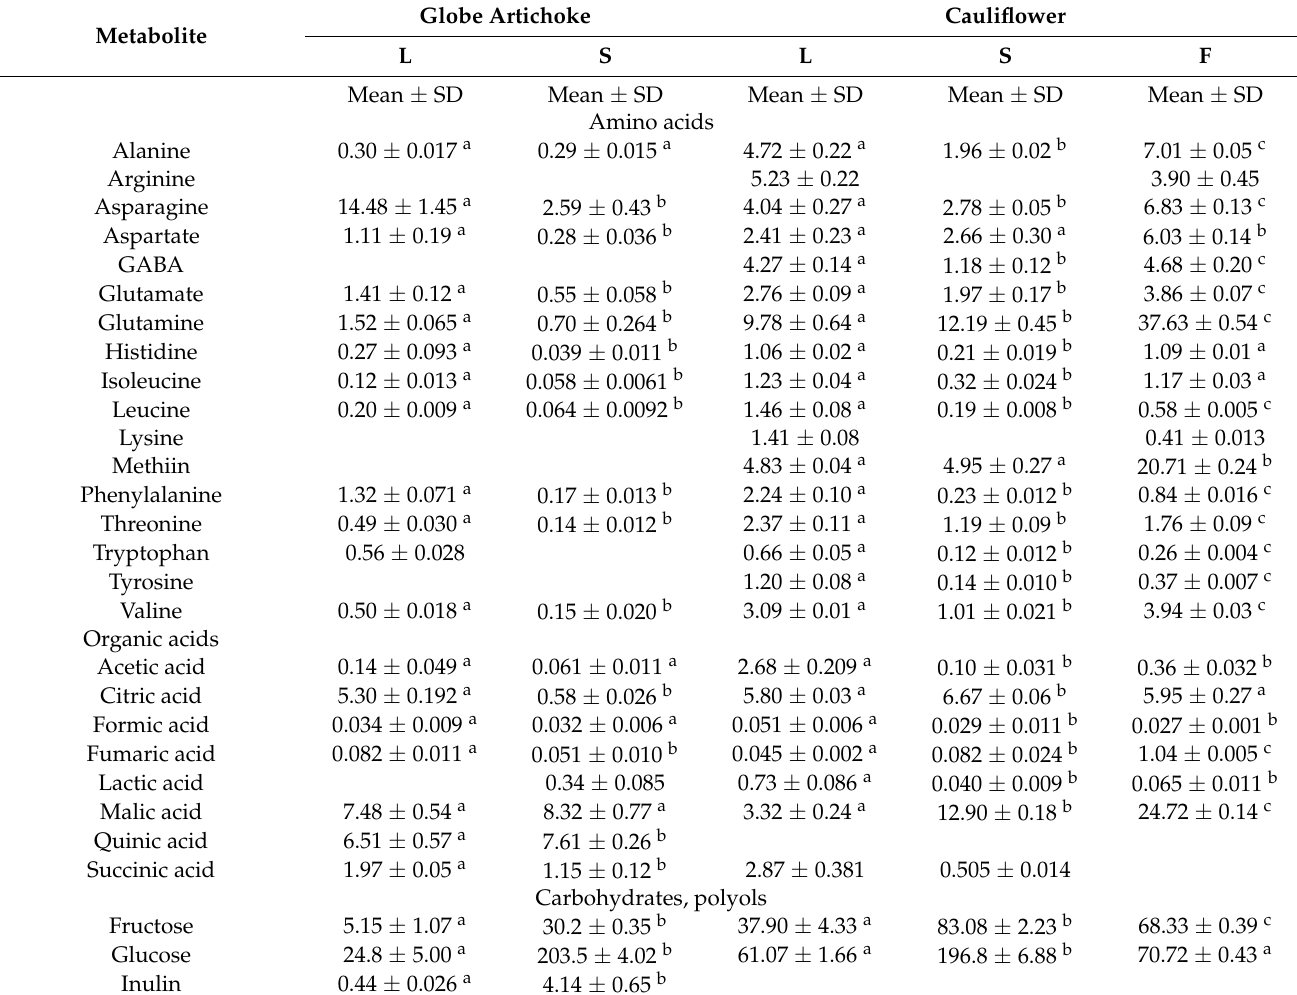
Table 4. Metabolite content (in mg/g DW) in aqueous extracts of cauliflower and globe arti- choke